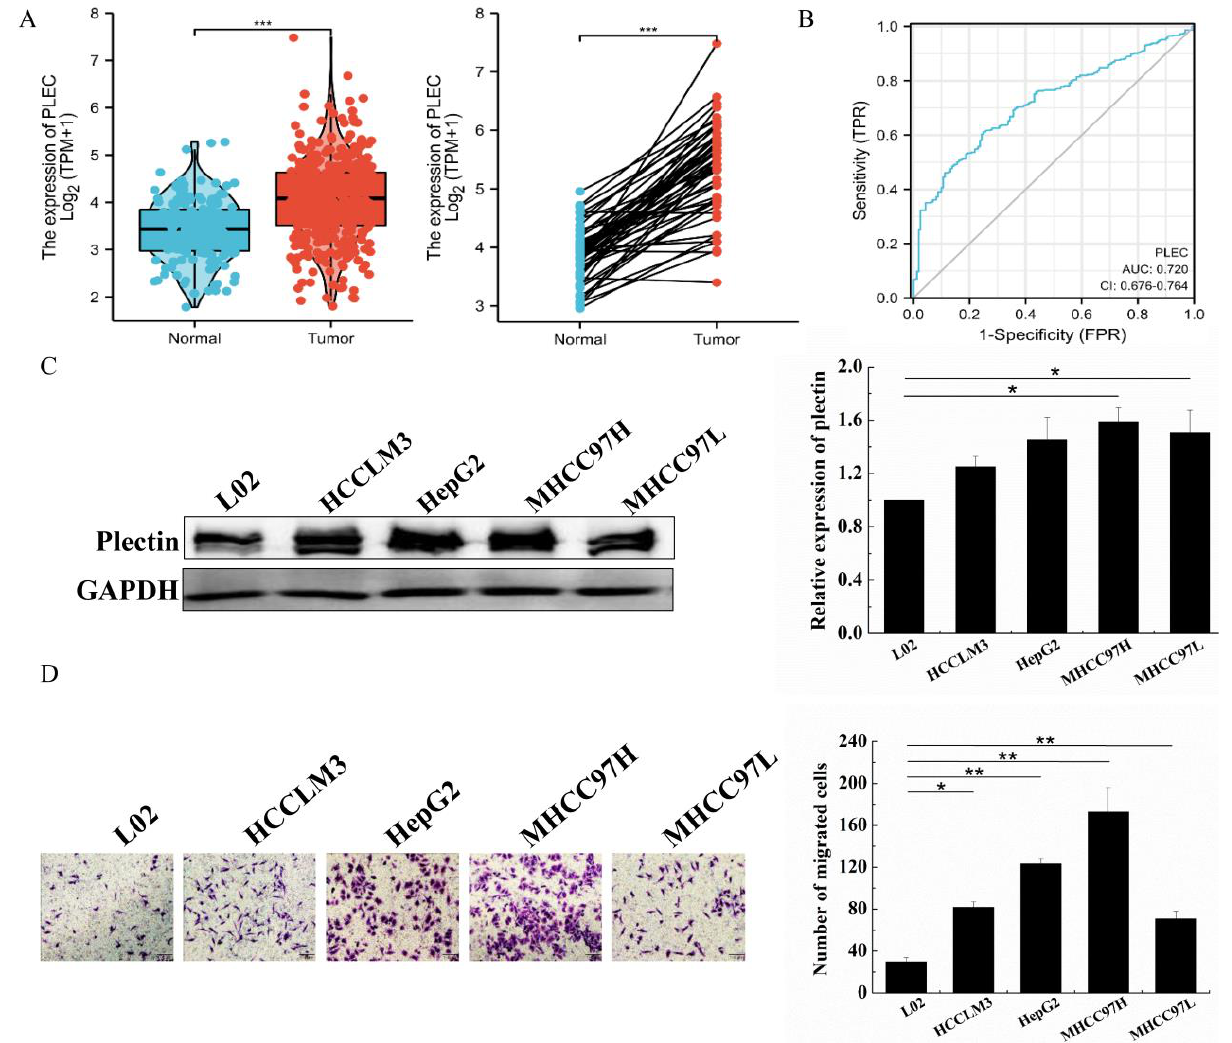
Figure 1. Plectin expression is upregulated in HCC tissue/cells and promotes HCC cell migration. ( A ) Plectin mRNA expression in HCC and normal tissue with unpaired samples (left) and paired samples (right) from the UALCAN database. ( B ) ROC curve of plectin in HCC. ( C ) Western blot detection of plectin protein expression in a panel of HCC cell lines including HCCLM3, HepG2, MHCC97H and MHCC97L cells and human liver cell line L02. ( D ) Transwell assays for migration ability evaluation in a panel of HCC cell lines including HCCLM3, HepG2, MHCC97H and MHCC97L cells and human liver cell line L02. The number of cells were counted and averaged (scale bar, 100 µm). GAPDH: glyceraldehyde-3-phosphate dehydrogenase. Data are presented as mean with SD; n = 3, * p < 0.05; ** p < 0.01; *** p < 0.001.